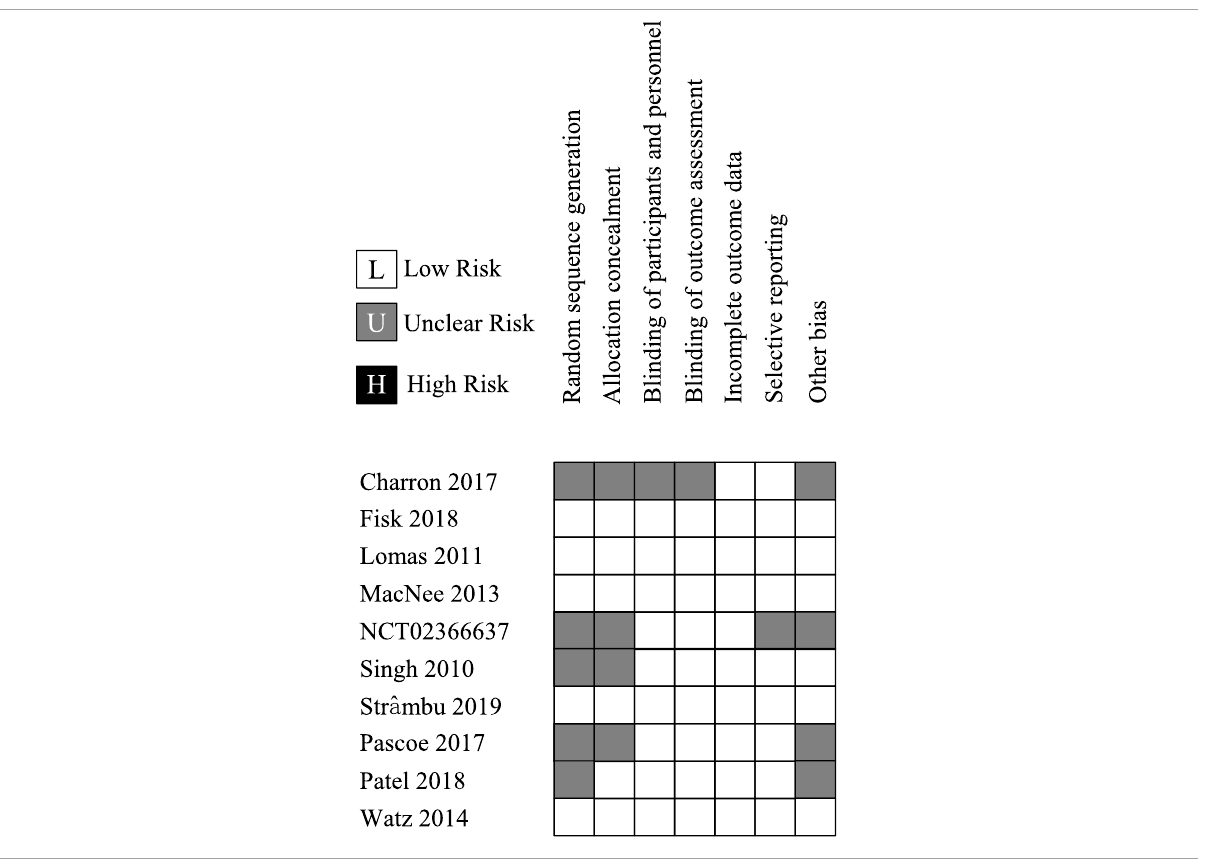
TABLE 4 Summary of the risk of